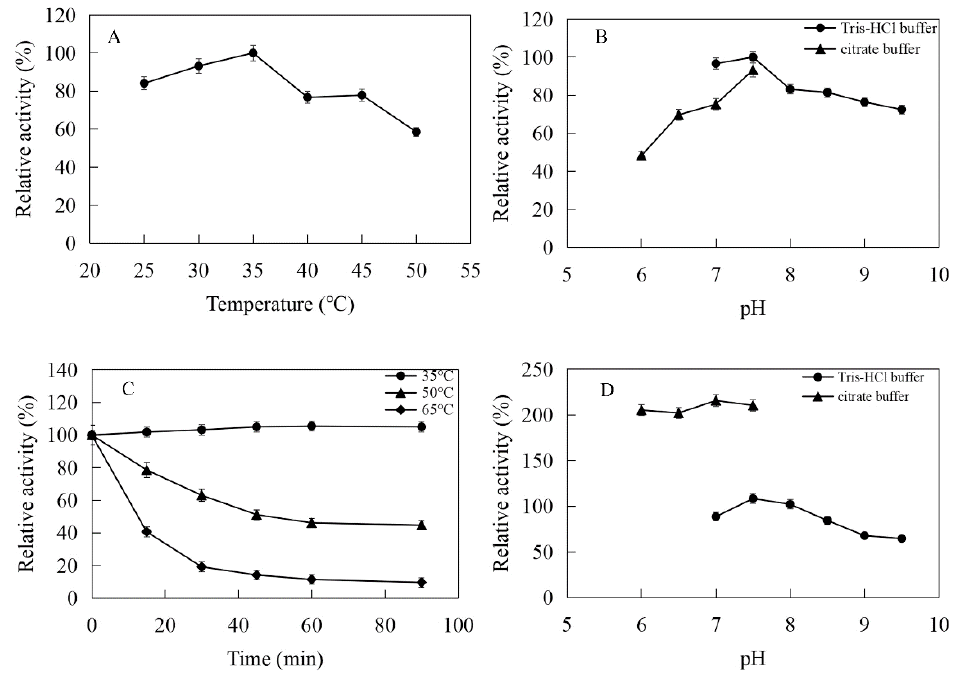
Figure 8. Effects of pH and temperature on the activity and stability of MtIPK: ( A ) Effect of temper- ature on the activity of MtIPK. ( B ) Effect of pH on the activity of MtIPK. ( C ) Thermostability of MtIPK. ( D ) pH stability of MtIPK.